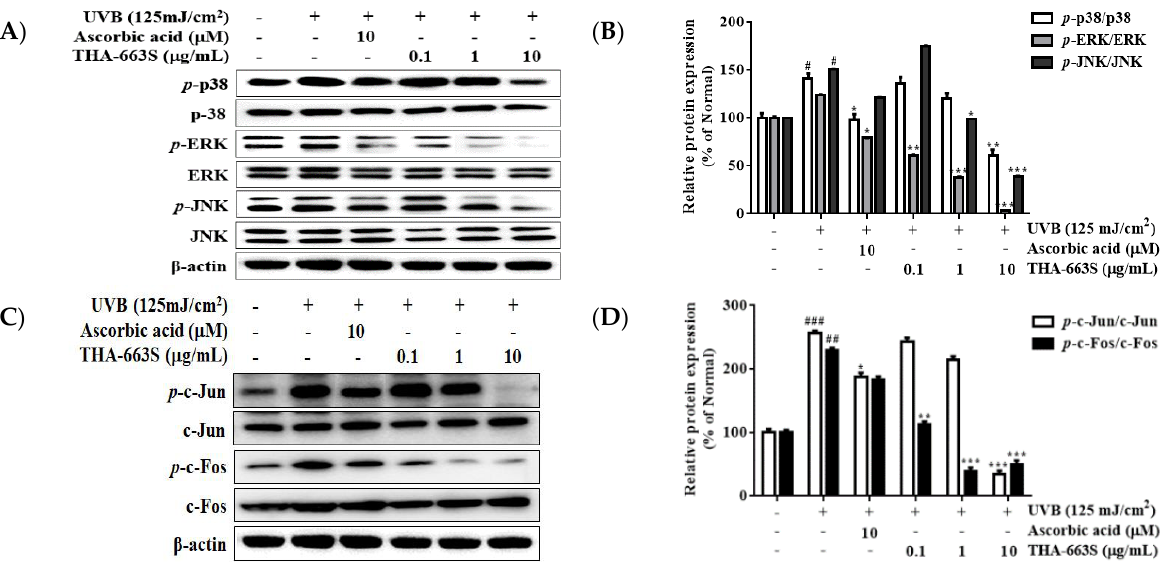
Figure 6. MAPK and AP-1 signaling protein expression in HaCaT cells of THA-663S. Following UVB irradiation (125 mJ/cm 2 ), HaCaT cells were treated with or without the indicated concentration of THA-663S (0.1, 1, and 10 µg/mL) for 1.5 h and 4 h. The p-p38, p-ERK, and p-JNK protein levels were measured using Western blotting ( A ). The band intensities were quantified by densitometry, normalized to the level of β -actin, and calculated as the percentage of the non-irradiated group ( B ). The p-c-jun and p-c-fos protein levels were measured using Western blot ( C ). The band intensities were quantified by densitometry, normalized to the level of β -actin, and calculated as the percentage of the non-irradiated group ( D ). The results are shown as the mean ± SD of three independent experiments. # p < 0.05, ## p < 0.01, ### p < 0.001 compared with non-irradiated group, * p < 0.05, ** p < 0.01, *** p < 0.001 compared with only UVB-irradiated group.